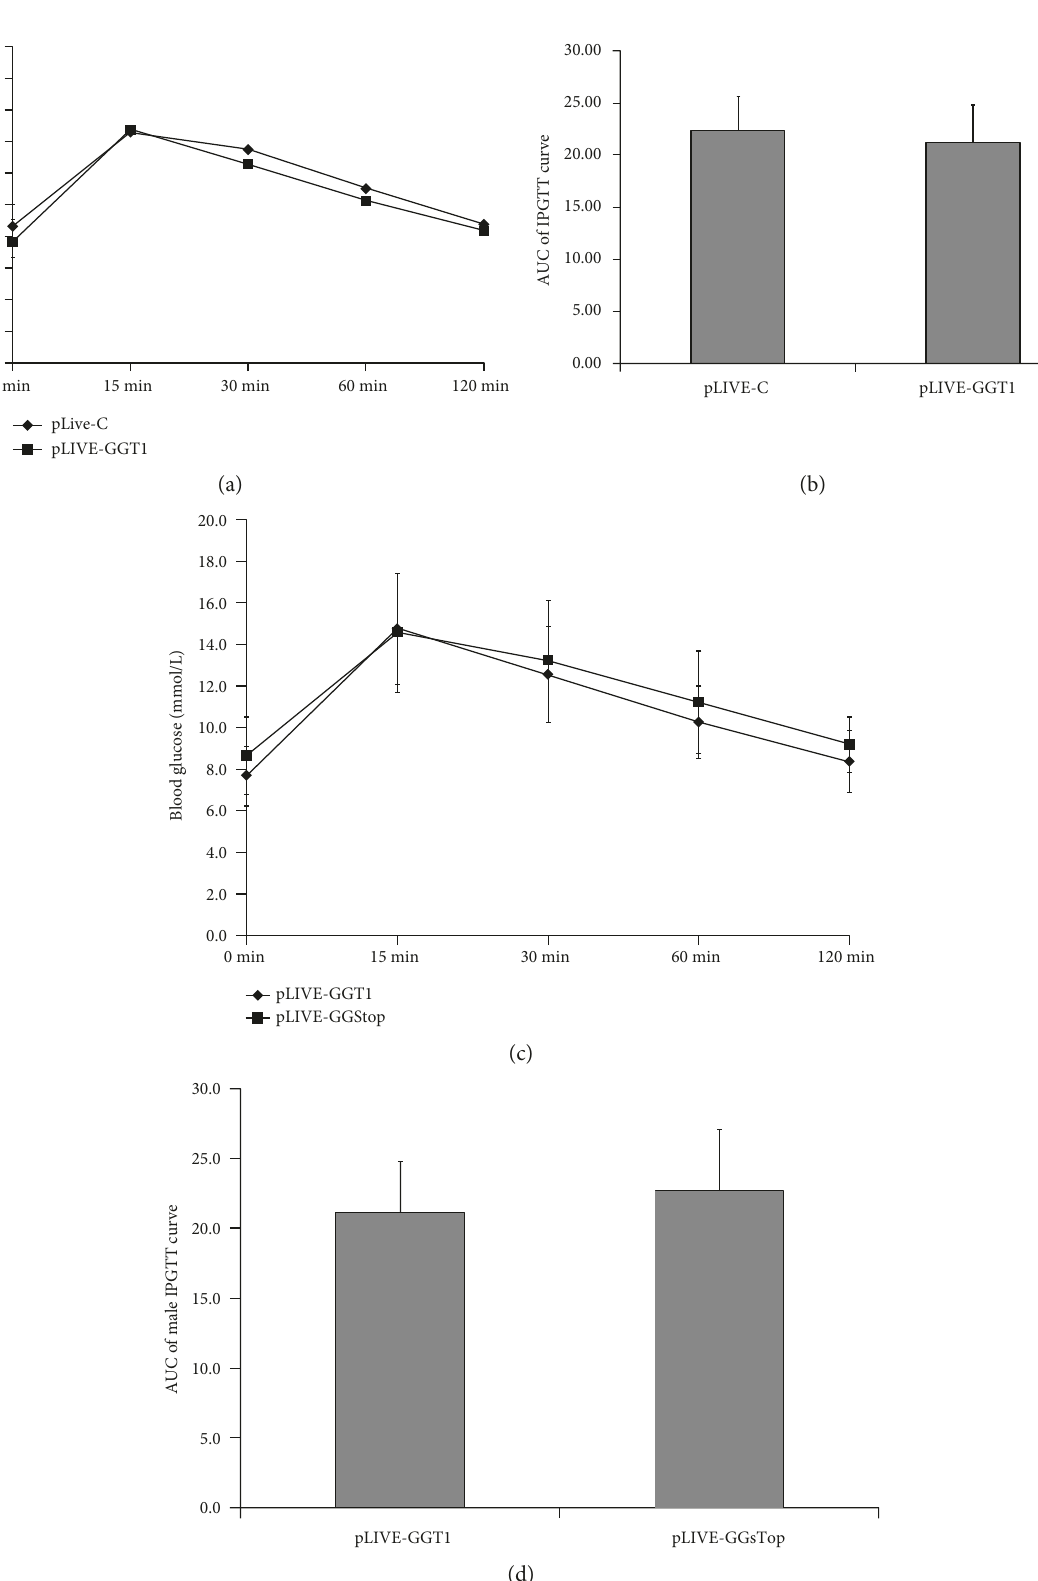
Figure 3: Overexpression of GGT1 in the liver had no e ff ect on glucose tolerance. (a) IPGTT was performed and the blood glucose was measured at the indicated time points ( n = 13 – 17 ); (b) AUC of the IPGTT curve. (c) IPGTT was performed in GGT1-L-OE mice and GGT1-L-OE-sTop mice which are treated with GGsTop, a highly selective GGT inhibitor, and the AUC was evaluated